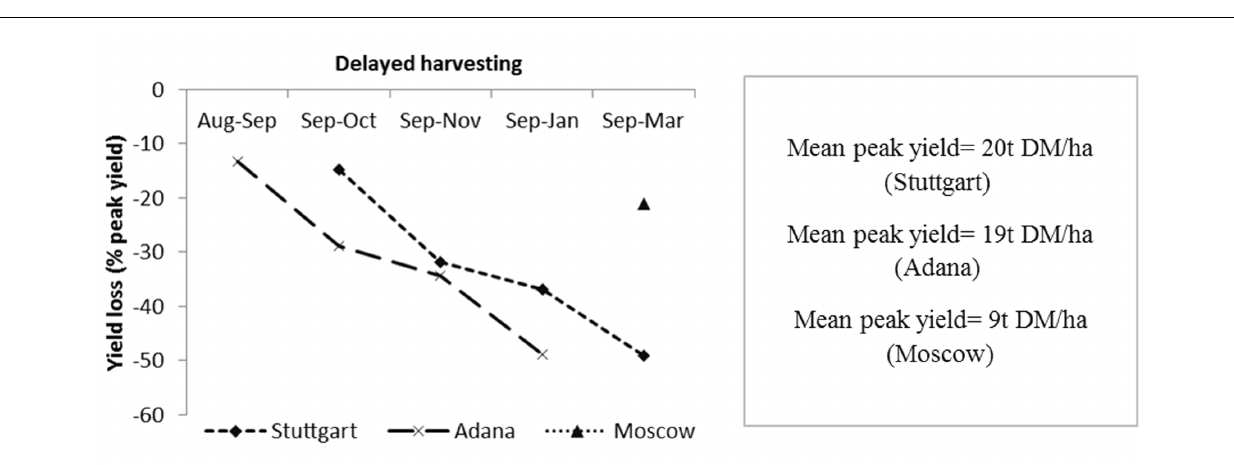
FIGURE 5 | Yield losses (%) with delay in harvesting time from peak yield for Stuttgart, Adana, and Moscow. The mean peak yield of all genotypes at each site is also